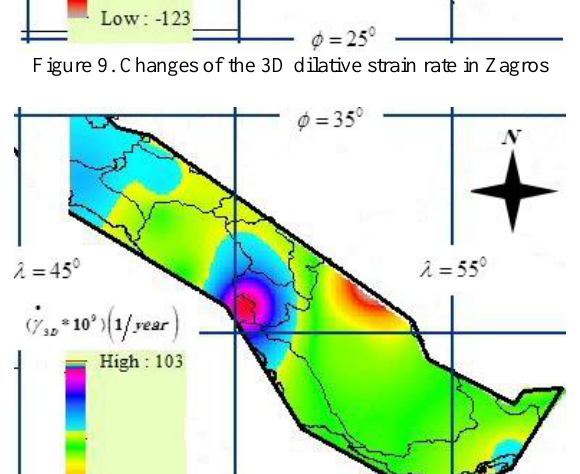
Figure 10. Changes of the 3D shear strain rate in Zagros If we consider the density of the earthquakes larger than 5 Richter, we can describe the above results more clearly. Figure (11) shows the location of these